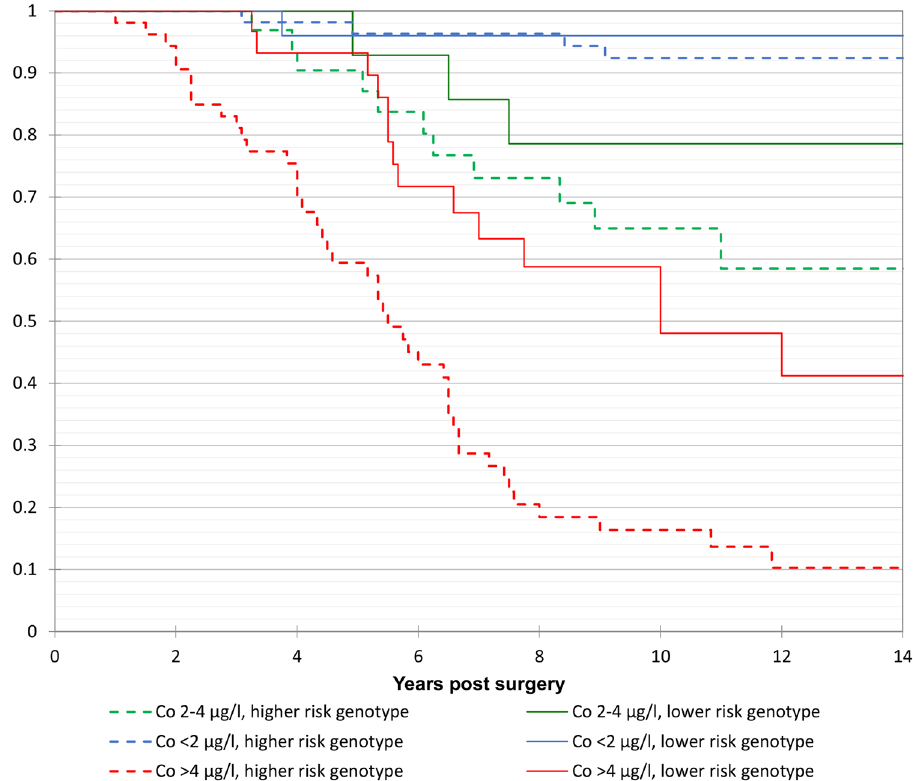
Fig. 4 Kaplan – Meier survival analysis including all female patients in the study. Failure secondary to ALVAL (mild/moderate/severe). The patients have been sub-grouped according to their HLA genotypes and blood Co concentration. Higher risk genotype de fi ned by the top 50% NTS binders, lower risk by the lowest 50%. Cox proportional hazards modelling using “ Co < 2, lower risk genotype ” as the reference group ( n = 55) returned hazard ratios (HR)(95% CI) of 1.95 (0.22 – 17.0) for Co < 2, higher risk genotype ( n = 25); 5.95 (0.62 – 57.2) for Co 2 – 4, lower risk genotype ( n = 32); 12.54 (1.62 – 97.2) for Co 2 – 4, higher risk genotype ( n = 14); 18.7 (2.45 – 142) for Co>4, lower risk genotype ( n = 53); 53.1 (7.26 – 388) for Co > 4, higher risk genotype ( n = 30).